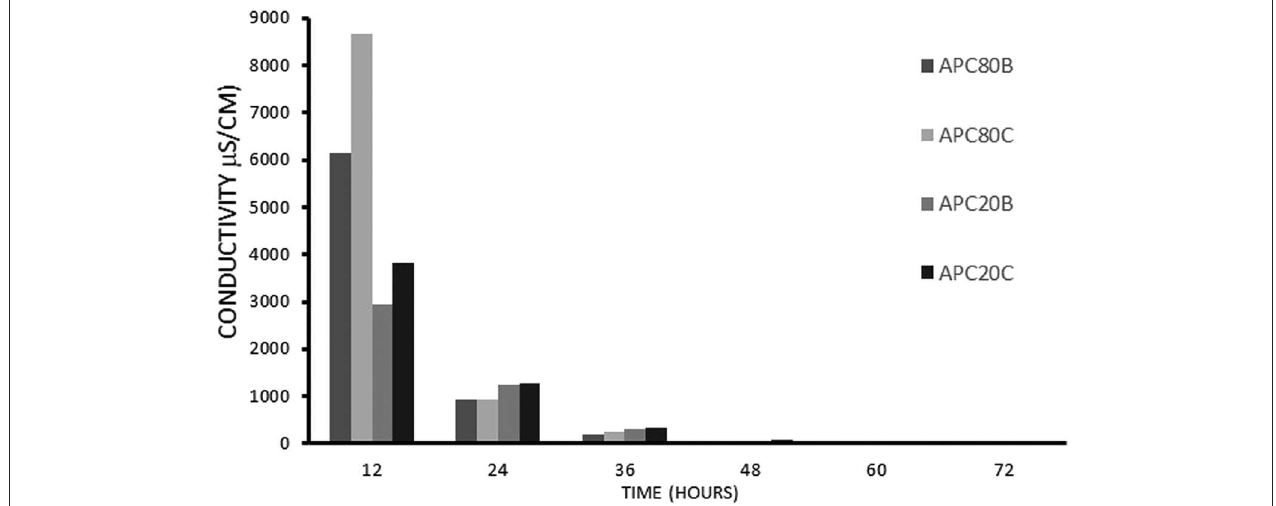
FIGURE 1 | The conductivity measurements on the aliquots of solvent obtained after immersion of the structures in methanol/water, B, or ethanol/water, C.